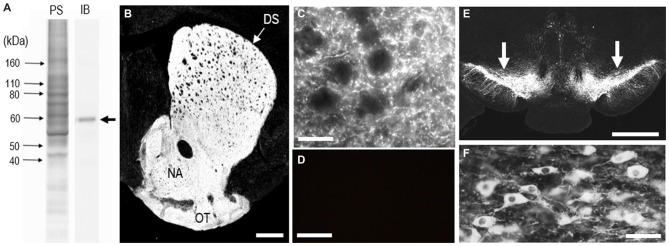
Identification of tyrosine hydroxylase (TH) in the mouse striatum. (A) Western blot assay. Crude homogenates of protein (10 μg) from the mouse striatum were separated on a 10% gel by SDS-PAGE and then immunoblotted using anti-TH antibody. An immunostained protein band (arrow) was selectively detected, with an approximate molecular mass corresponding to the predicted size of native TH protein. PS, protein staining; IB, immunoblot. (B) Photomicrograph of a striatal section stained for TH. TH immunoreactivity appears to be homogeneously distributed throughout the dorsal striatum (DS). (C) Photomicrograph of the striatal area stained for TH. Numerous tiny TH-positive dots were found in the striatum. (D) Photomicrograph of the DS processed using the immunostaining protocol without anti-TH antibody. (E) Photomicrograph of the midbrain stained for TH. Arrows indicate the substantia nigra pars compacta (SNc). (F) Photomicrograph of nigral dopaminergic cells positive for TH. Abbreviations: DS, dorsal striatum; NA, nucleus accumbens; OT, olfactory tubercle. Scale bars: (B) 500 μm, (C,D) 20 μm, (E) 1 mm, (F) 50 μm.